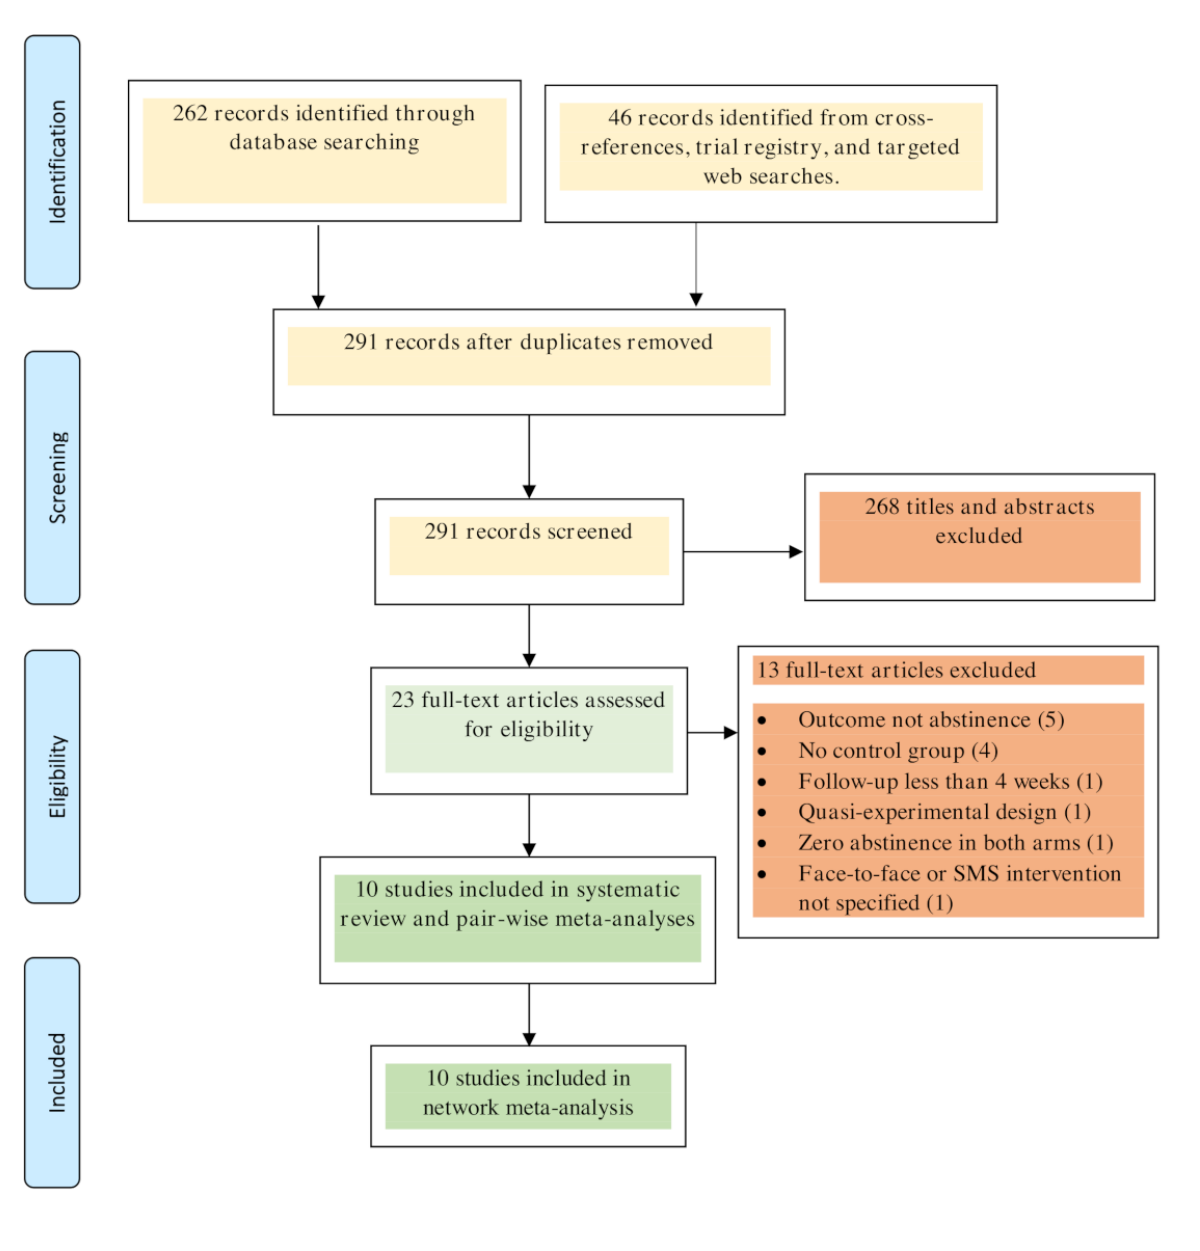
Figure 3. Study selection flow diagram. SMS: short message